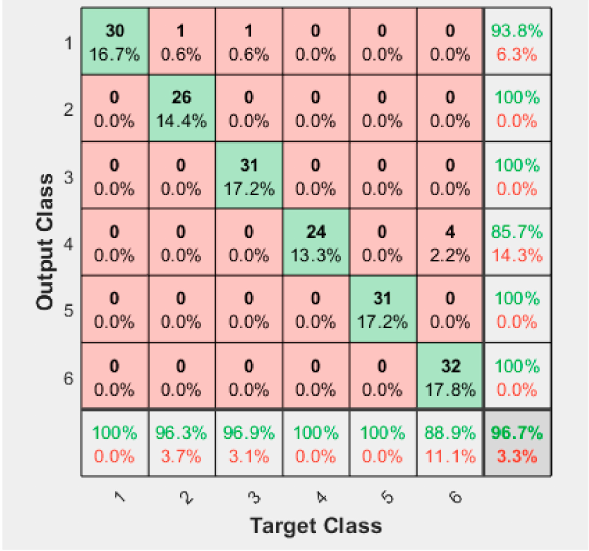
Figure 10. Confusion matrix for classification model with db4